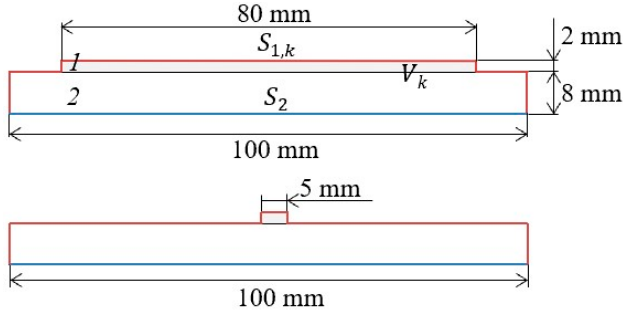
Figure 1. Modeled geometry: the calculated scheme of the problem: ( 1 ) the domain occupied by the final product; ( 2 ) the platform on which deposition is carried out; V k —the domain occupied by platform and part of the printed sample at the k-th sub-stage of the solution; S 1, k —free surfaces of the platform and part of the printed sample at the k-th sub-stage of the solution; S 2 —heated platform surface.